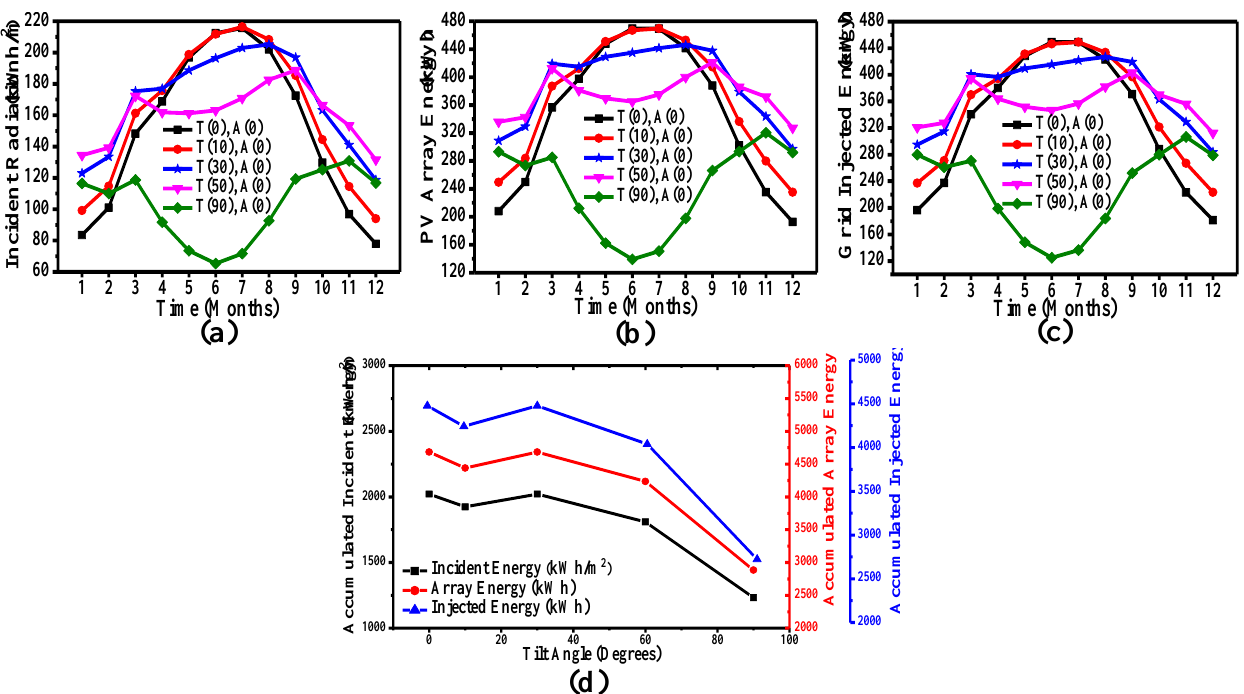
Figure 6: [T(x), A(0)] configuration: (a) incident radiation received by the module surface, (b) generated energy by the array, (c) energy injected to the grid, and (d) accumulated incident, generated, and injected energies over one year.